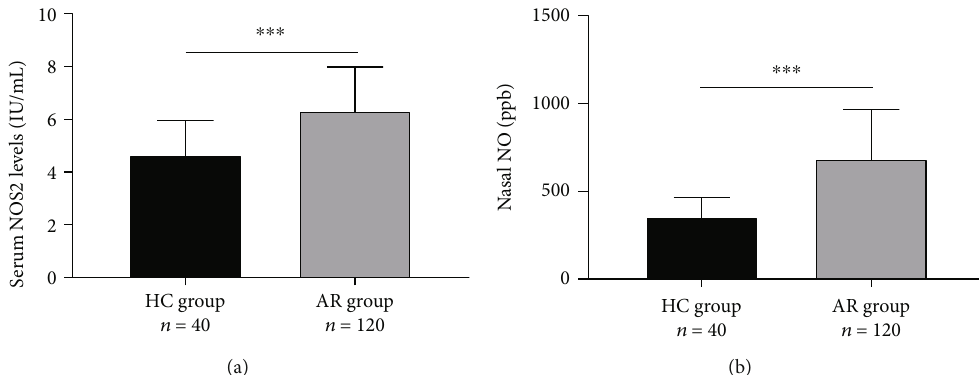
Figure 1: The levels of serum NOS2 and nNO in between the HC group and AR group. (a) Compared to the HC group, the serum levels of NOS2 were signi fi cantly increased in the AR group. (b) The nNO levels were notably higher in the AR group than HC group. NOS2: inducible nitric oxide synthase; nNO: nasal nitric oxide; HC: health control; AR: allergic rhinitis, ∗∗∗ P < 0 : 0001 .